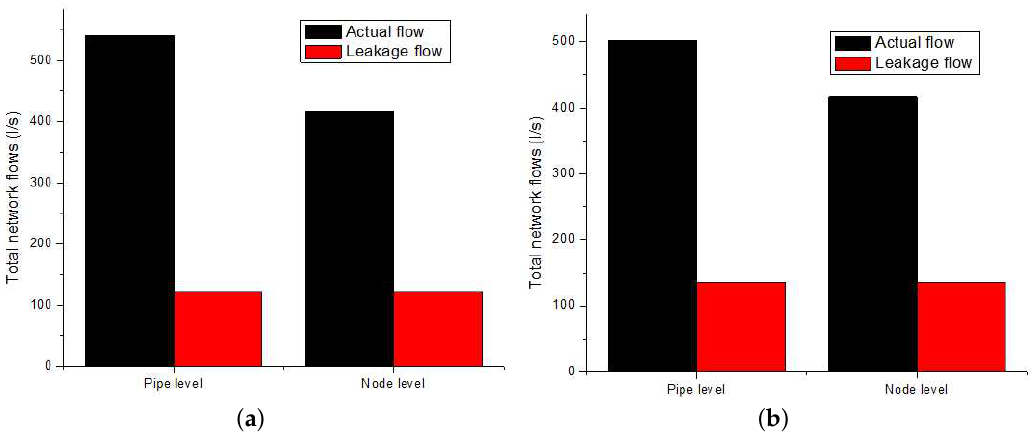
Figure 4. Total network leakage flow with respect to the nodal demand and pipe discharges for the case study network 1: ( a ) DDM analysis; ( b ) PDM